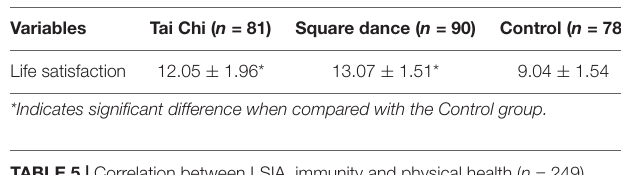
TABLE 4 | Life satisfaction of the participants in the three groups ( n = 249).